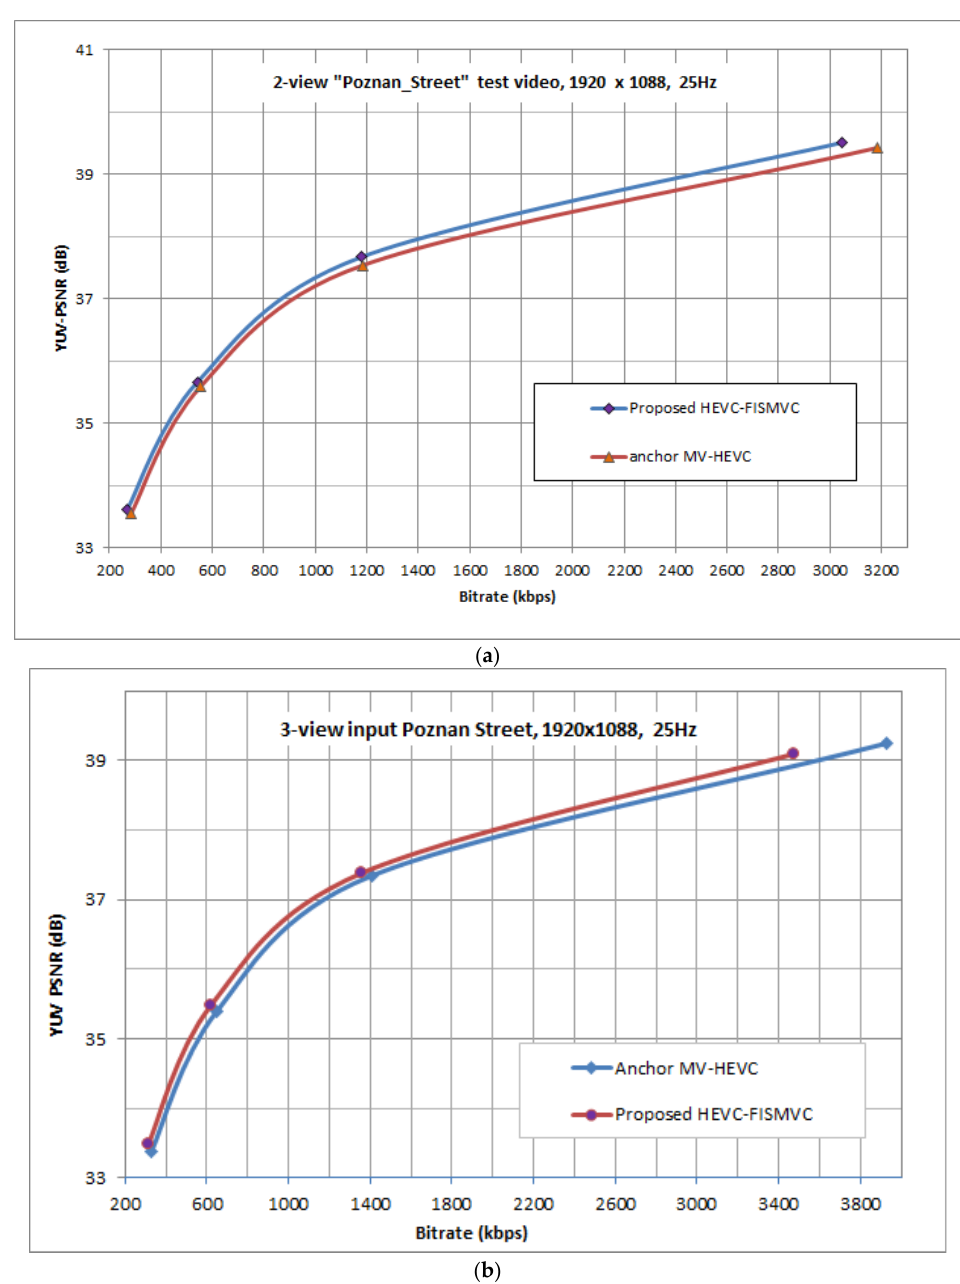
Figure 4. Average YUV-PSNR vs bitrate of the anchor MV-HEVC and the proposed HEVC-FISMVC